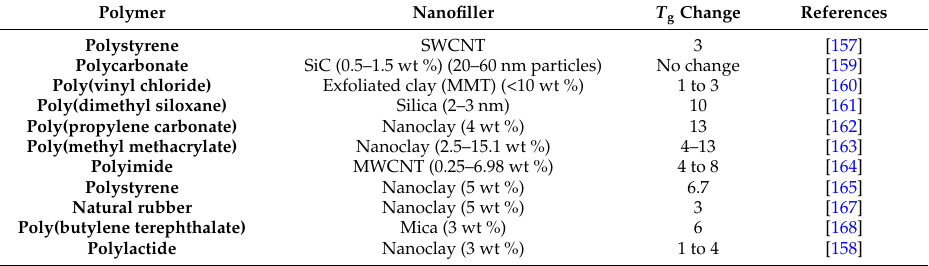
Table 2. Glass transition changes with nano-filler incorporation. SWCNT = single-walled